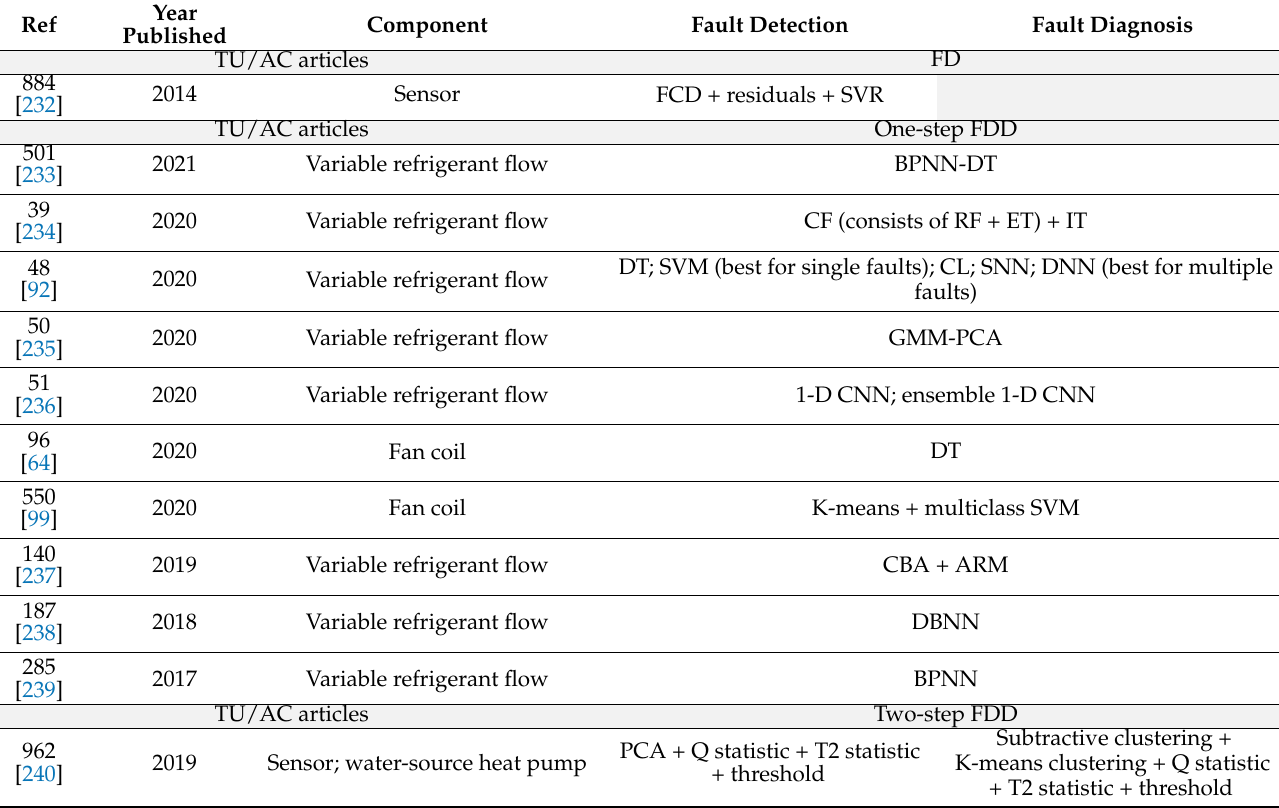
Table A3. Energy conversion: terminal unit/Air-conditioning